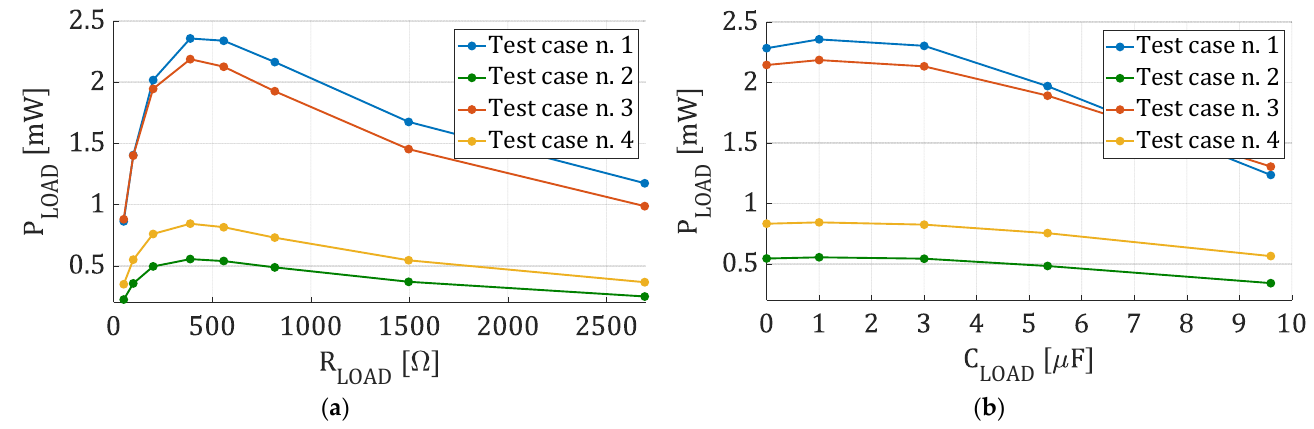
Figure 13. Measured average load power for the single coil circuit in Figure 8, in the four test cases. ( a ) Power as a function of the load resistance for the optimal load capacitance. ( b ) Power as a function of the load capacitance for the optimal load resistance.